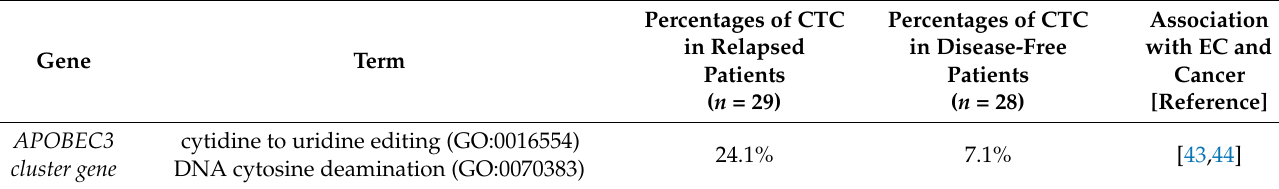
Table 2. List of mostly associated genes of the six terms distinctive in CTCs from relapsed patients. CTC: circulating tumor cells; GO: Gene Ontology; EC: esophageal cancer.